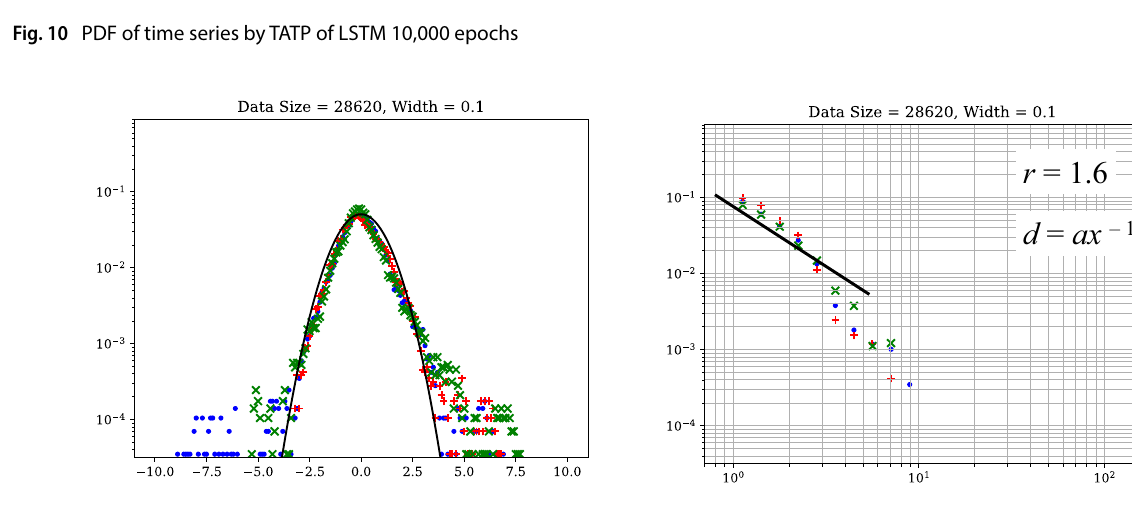
Fig. 11 PDF of time series by DFTS of LSTM 1000